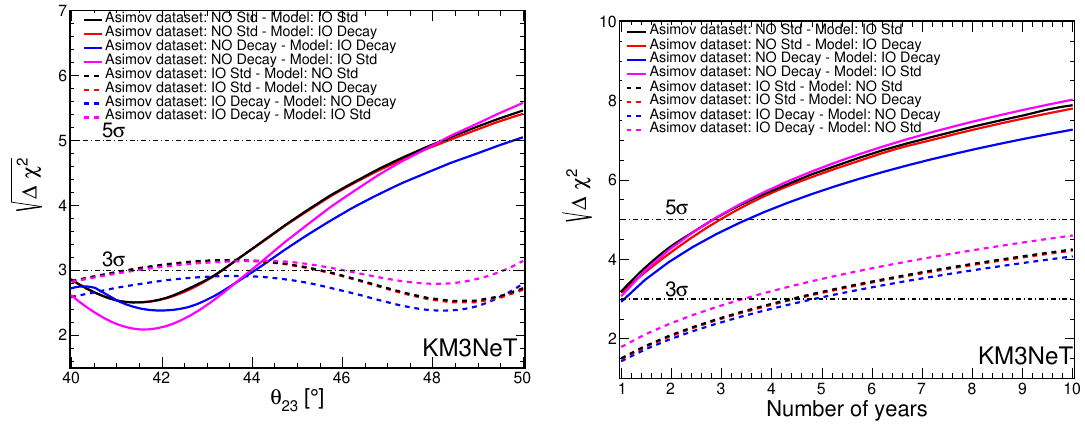
Figure 13. Left: NMO sensitivity assuming true NO (solid) and true IO (dashed) for 3 years of data taking as a function of the true value of θ 23 . Right: NMO sensitivity assuming true NO (solid) and true IO (dashed) for θ 23 = 48 . 6 ◦ as a function of the number of years of data taking. Four cases are considered: standard oscillations in both the Asimov dataset and the model (black), standard oscillations in the Asimov dataset and α 3 free in the model (red), Asimov dataset assuming a decay scenario ( α 3 = 1 . 22 × 10 − 5 eV 2 ) and α 3 free in the model (blue), and Asimov dataset assuming a decay scenario ( α 3 = 1 . 22 × 10 − 5 eV 2 ) but assuming standard oscillations in the model